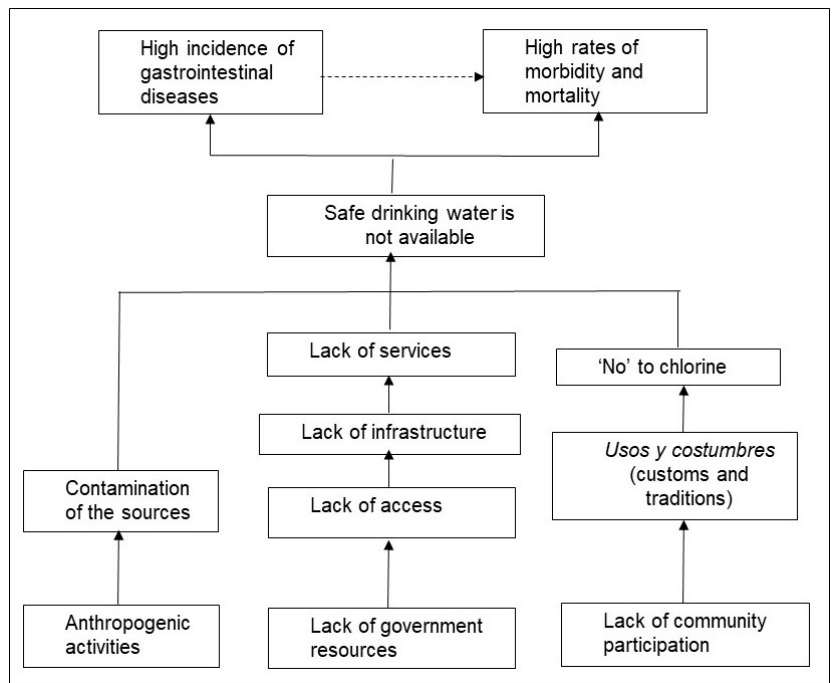
Figure 5 . The water problem and perceptions of stakeholders working with ICs in Los Altos, Chiapas, Mexico